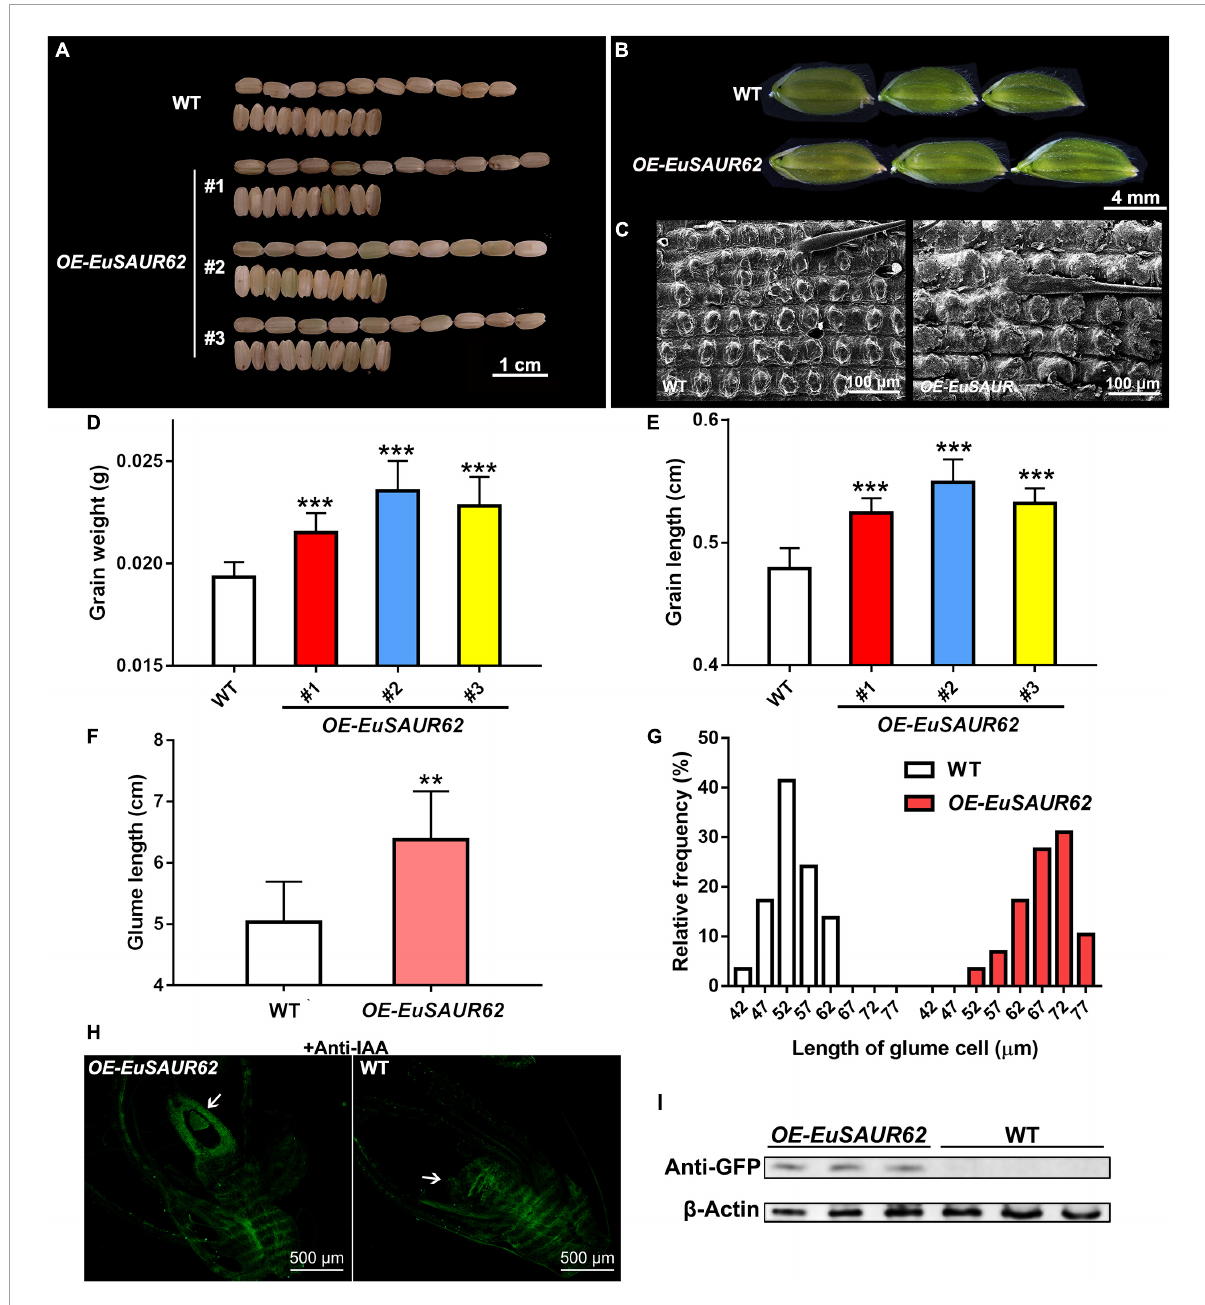
FIGURE5 Grain size and histology comparison of the WT and OE-EuSAUR62 rice. After harvest, (A) morphologies of the mature grains produced by OE-EuSAUR62 and WT were observed. The grains generated by the OE-EuSAUR62 were significantly longer than that of WT. Scale bar = 1 cm. Histological analysis of the glumes (B) and outer glume cells (C) at heading stage. The glumes of WT and transformant were observed using a stereo microscope (Scale bar = 4 mm). The outer glume cells were observed under a scanning electron microscope (Scale bar = 100 µ m). After harvest, 10 grains per line were collected randomly for size and weight measurement. OE-EuSAUR62 significantly improved the grains in weight (D) and length (E) compared with the WT. The glume length of OE-EuSAUR62 rice was longer than the WT (F) . Length of the outer glume cells was longer in OE-EuSAUR62 rice compared to the WT (G) . Statistical count is shown as the frequency distribution of the cell length. (H) Localization of IAA in the rice ovary (white arrow) of WT and OE-EuSAUR62 at the flowering stage (Scale bar = 500 µ m). (I) The expression of EuSAUR62 was detected using western blot analysis with an anti-GFP antibody. The β -actin was used as an internal control. The negative controls are represented in the supplementary material . Data are mean ± SD. One-way ANOVA and post hoc statistical analysis was performed (** p < 0.01, *** p < 0.001). OE-EuSAUR62 , EuSAUR62 overexpression lines; WT, wild type